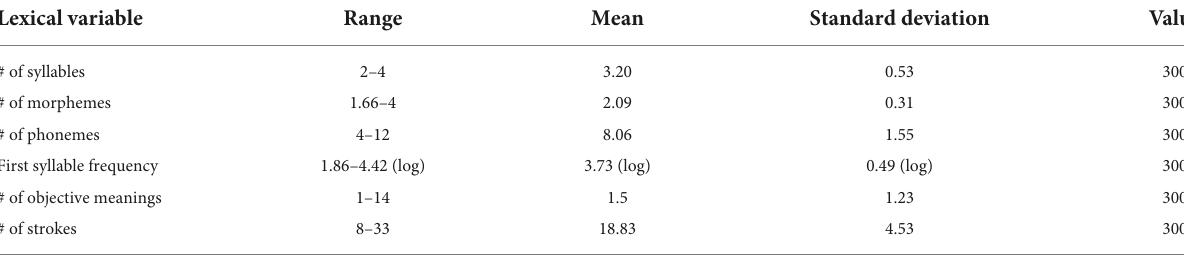
TABLE 2 Descriptive statistics of the lexical variables of stimuli in experiment.